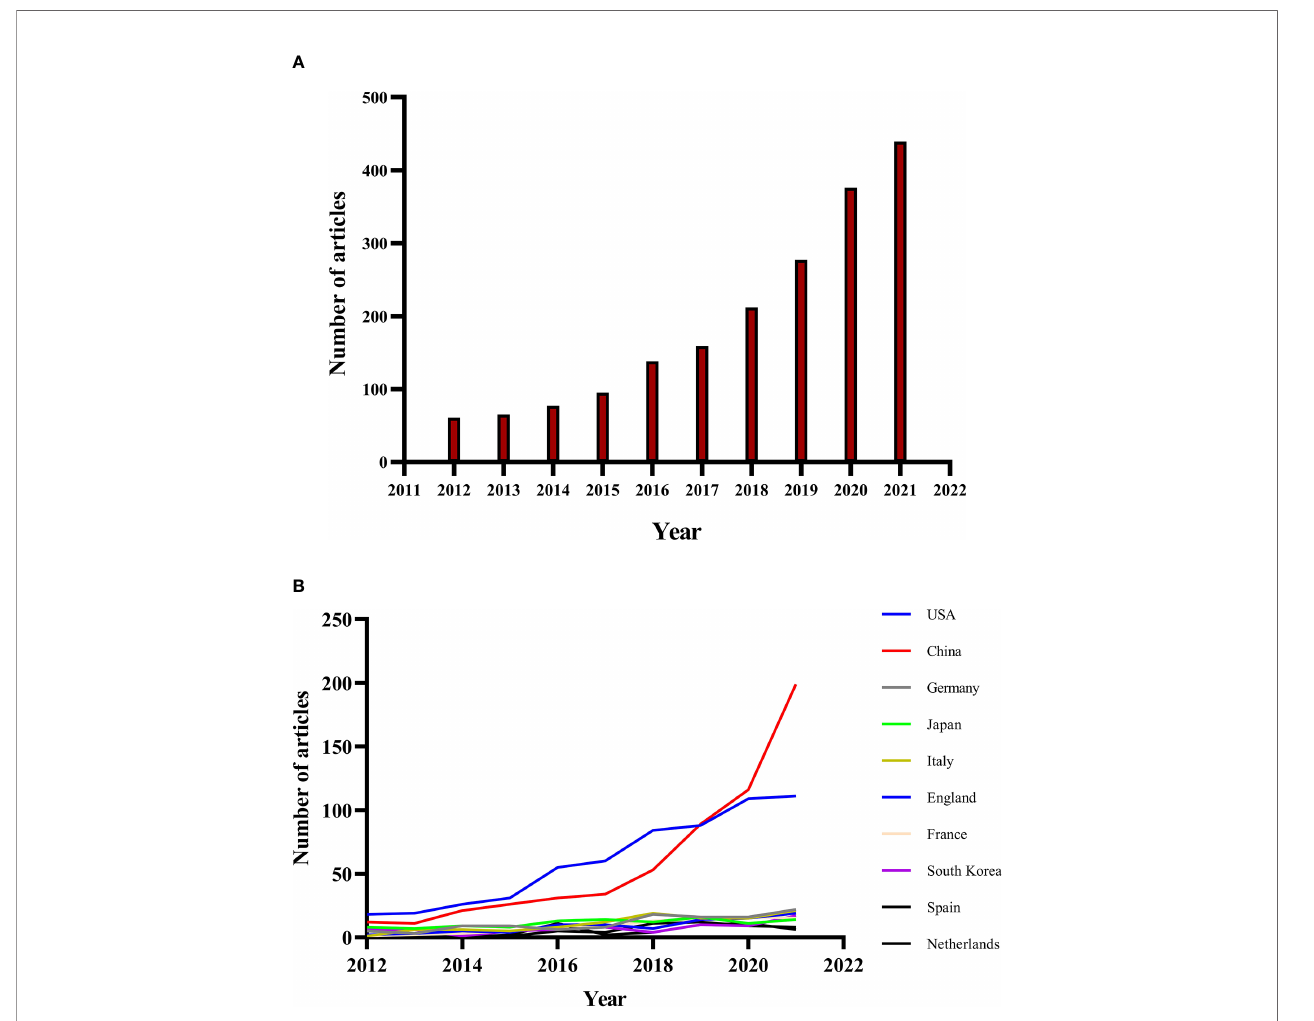
FIGURE 2 | (A) Annual publications of immunotherapy in colorectal cancer from 2012 to 2021. (B) The country ’ s annual trend publications related to colorectal cancer immunotherapy from 2012 to 2021.